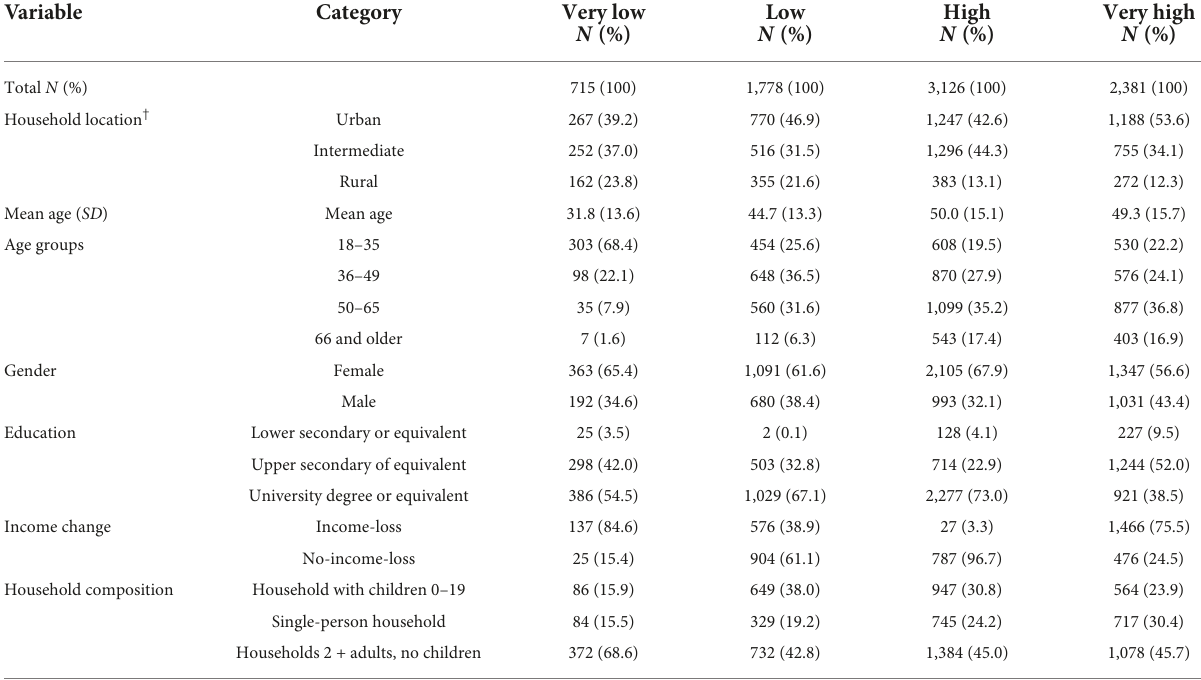
TABLE 3 Description of the AIC groups socio-economic and demographic: weighted data analysis.